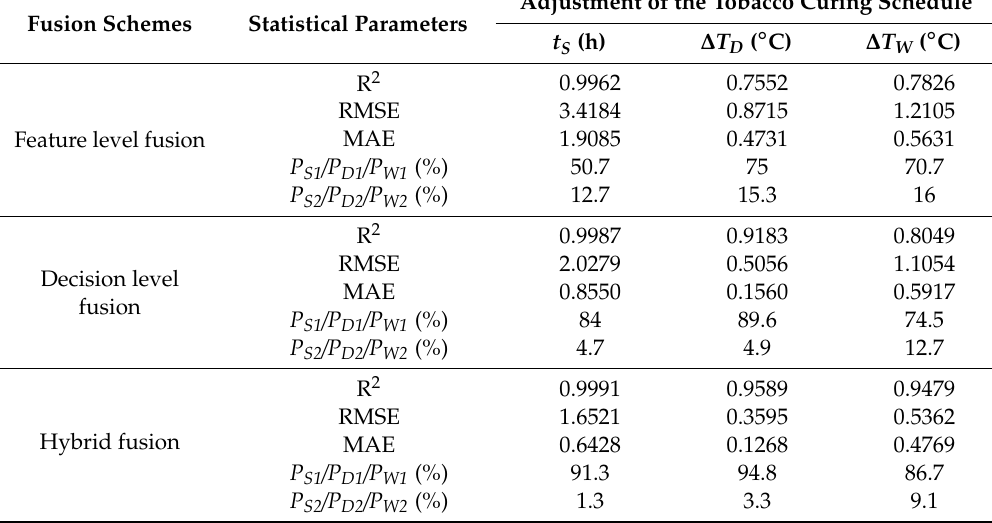
Table 3. The performance comparison of di ff erent fusion schemes on intelligent control of tobacco